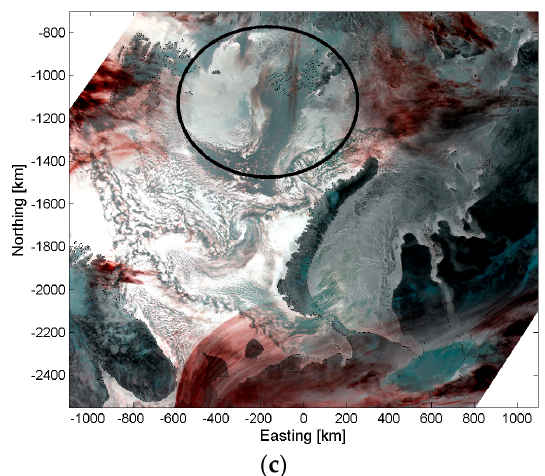
Figure 8. ( a ) Terra MODIS MOD29 ice surface temperature chart on 11 January 12016, 08:55 UTC, ( b ) the same chart after further cloud masking using the procedure developed here, and ( c ) MODIS RGB-image from bands 20-31-32. MODIS sensor scan angle was limited to be less than 40° in ( a ) and ( b ). Dark blue colour in ( a ) and ( b ) shows combined cloud, scan angle and no-data mask (an area outside the imaging swath). Vertical bar shows the IST scale in Kelvins. Black ellipse in ( c ) shows an area which is cloudy by visual analysis, but mostly assigned as cloud-free in ( a ).